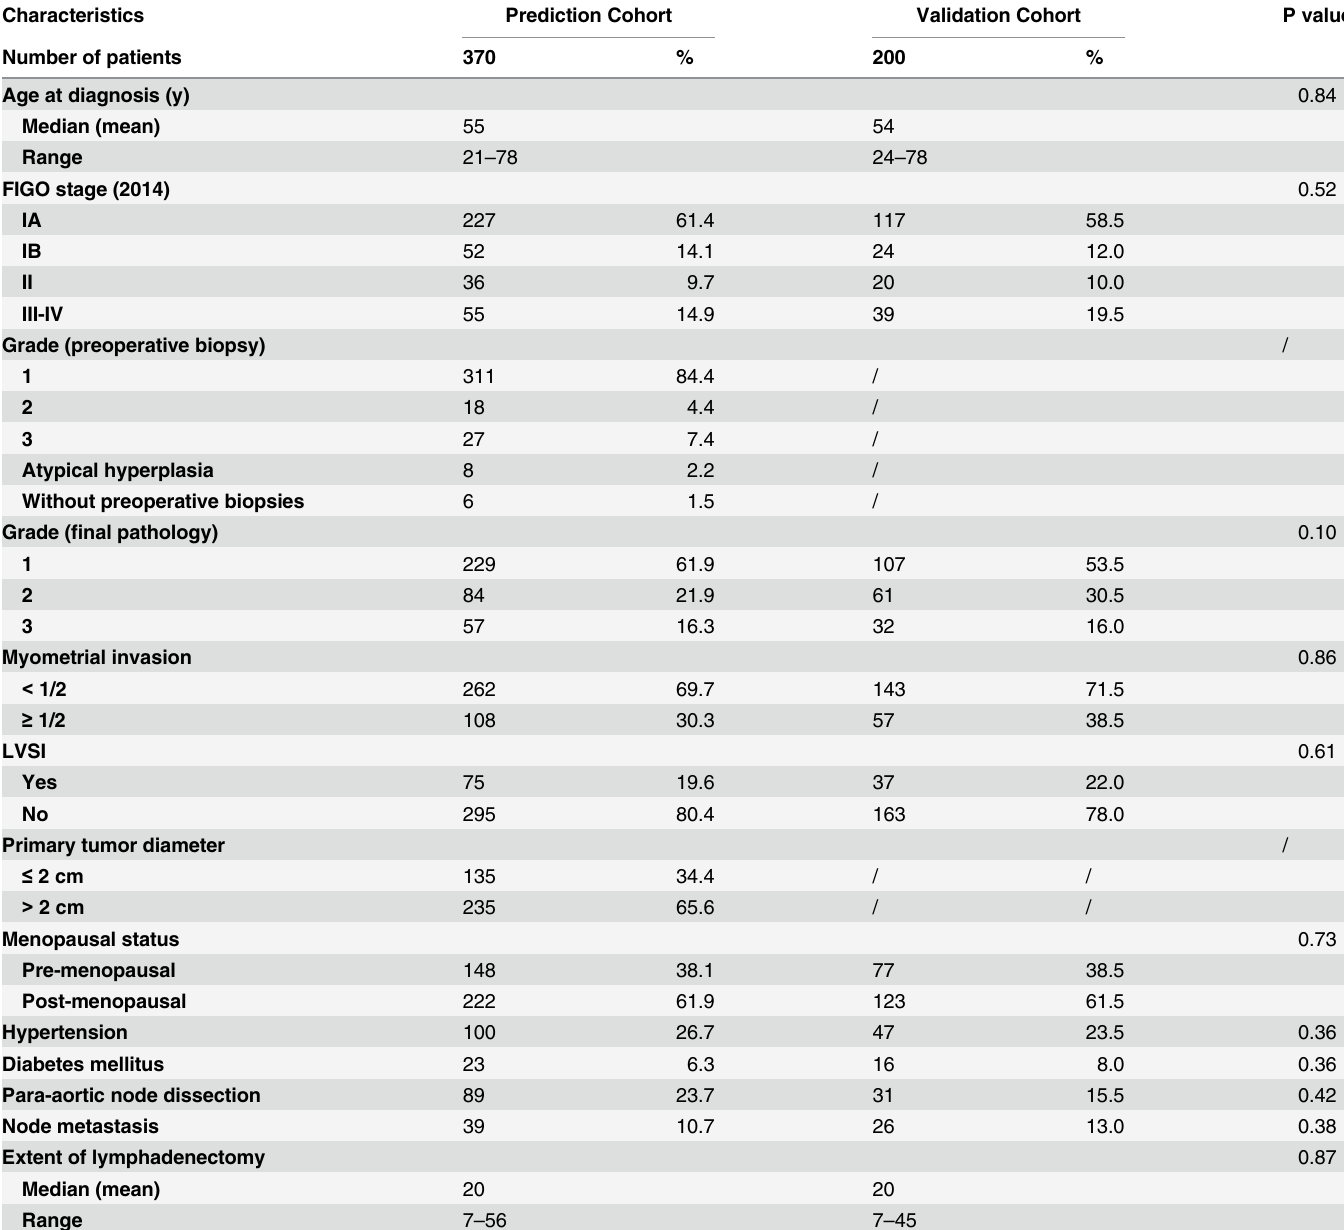
Table 2. Basic characteristics of prediction cohort and validation